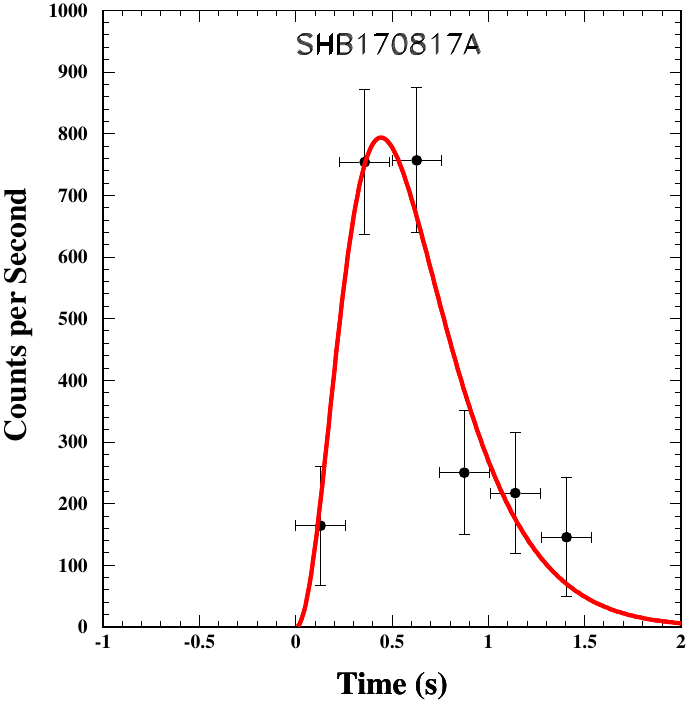
Figure 9. The pulse shape of SHB170817A measured with the Fermi-GBM [25–29] and the best fit pulse shape given by Equations (6) and (7) with ∆ = 0.62 s and τ = 0.57 s, χ 2 /dof =